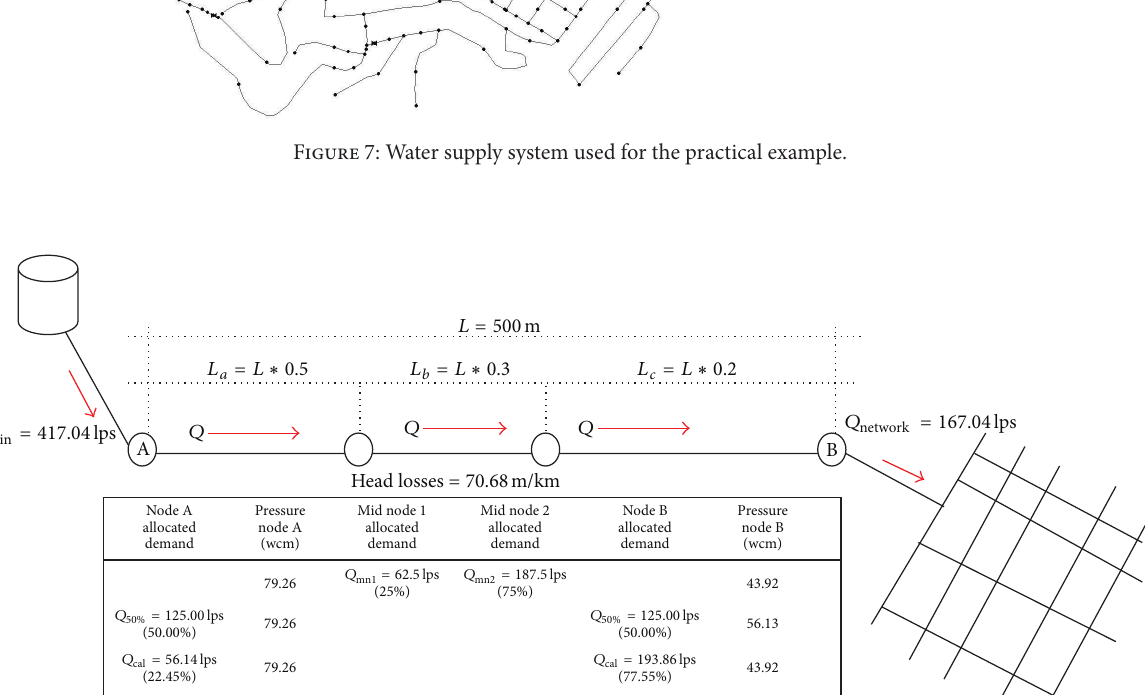
Figure 8: Details and results for Case